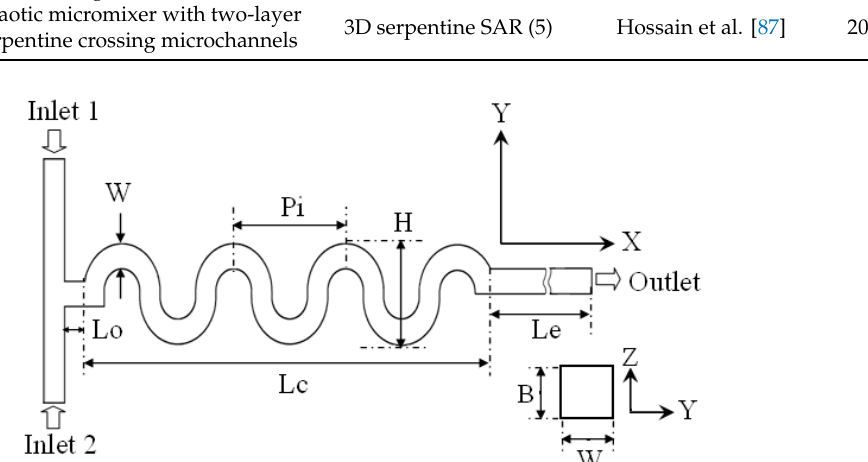
Figure 1. Curved micromixer: M ‐ 1 (no. of mixing units used: 8). Reproduced with permission from